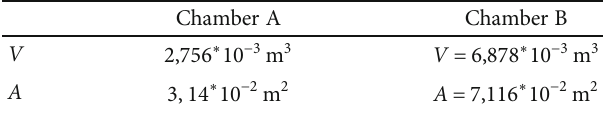
Table 3: Speci fi cations of the accumulation chambers (West